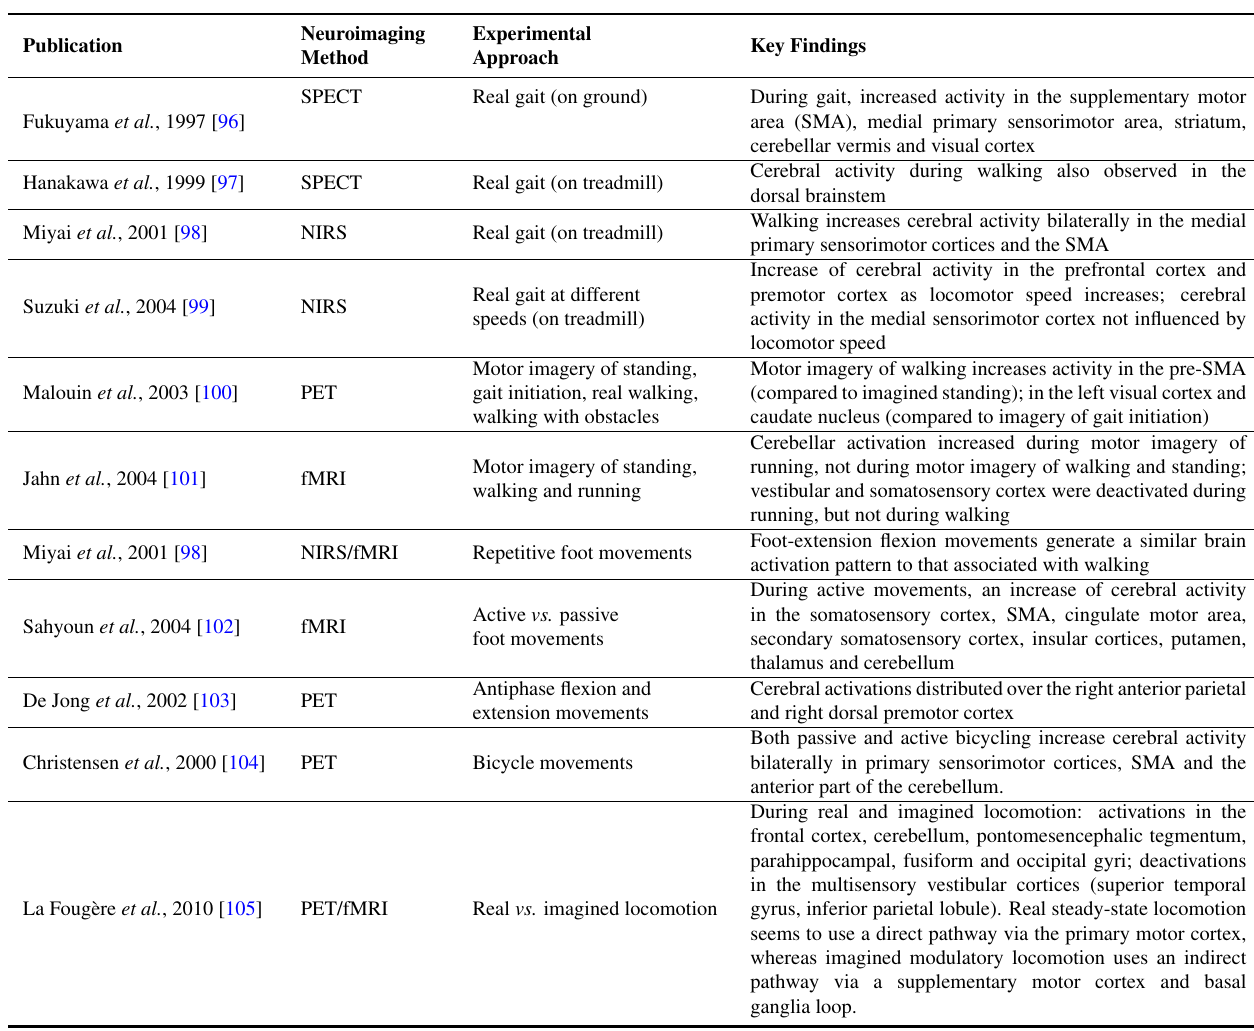
Table 3. An overview of the results obtained by different functional neuroimaging studies of gait in healthy